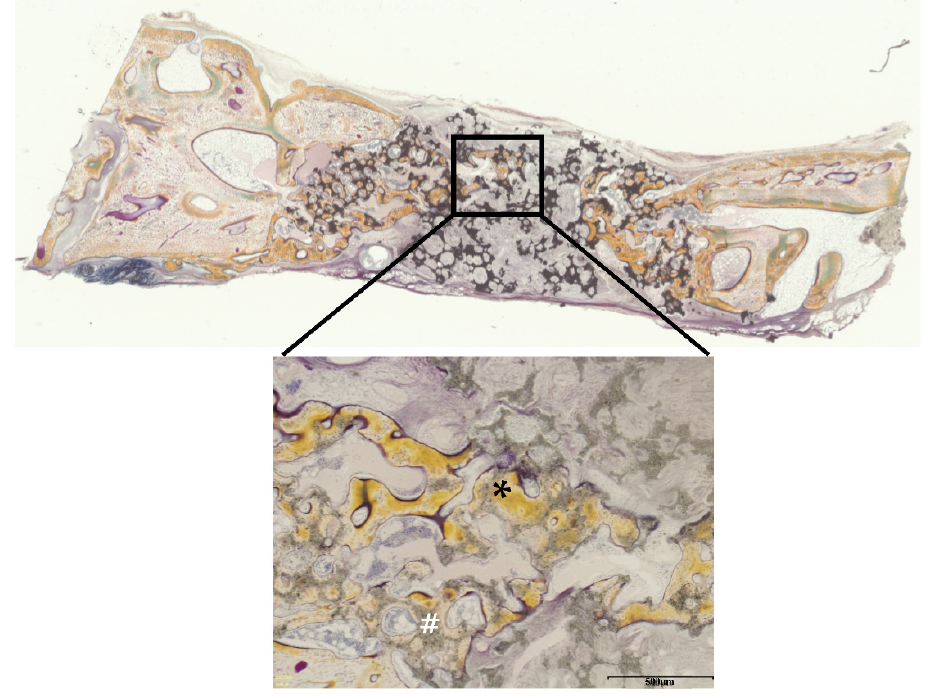
Figure 15. Villanueva bone stain images four weeks after filling with HA granules. (*: newly formed bone, #: HA granules, scale bar: 500 μ m).